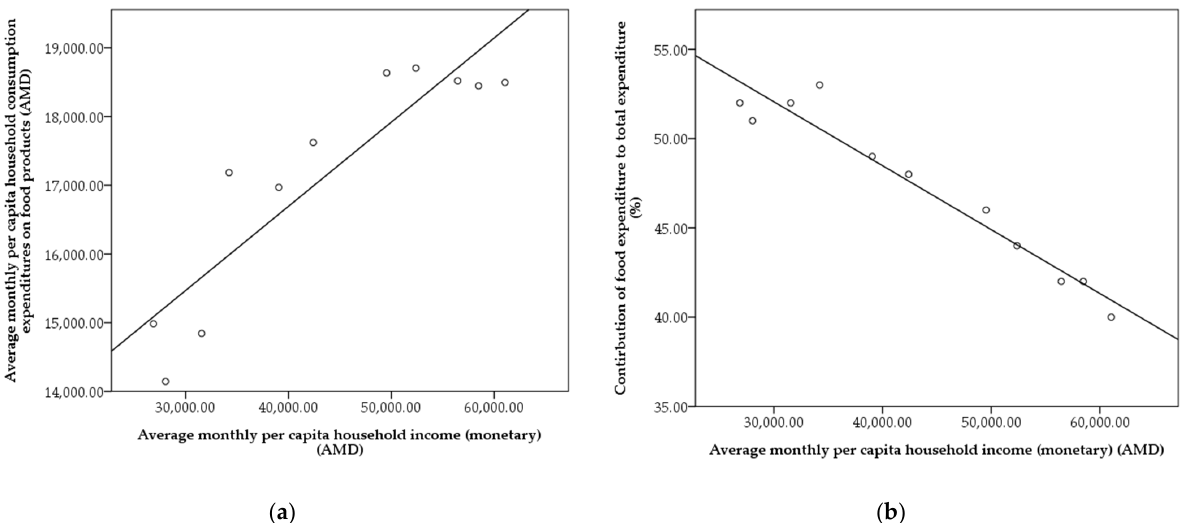
Figure 5. Relationship between per capita household income and food expenditure ( a ), and relationship between per capita household income the share of food consumption expenditure to total expenditure ( b ). Armenia. 2008–2019.